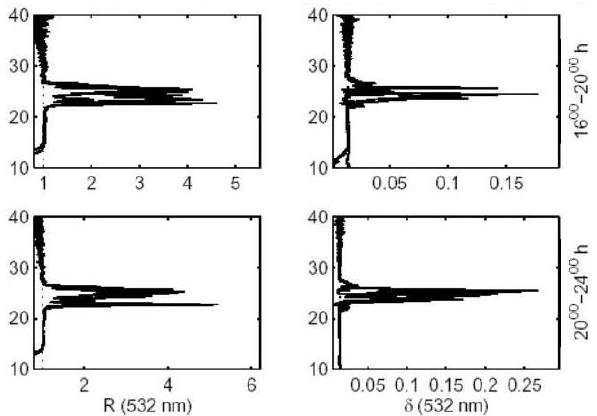
Fig. 7. LIDAR measurements from the Koldewey Station in Ny- ˚Alesund on 7 December 2002. The signals are time averaged Figure 7. LIDAR measurements from the Koldewey Station in Ny-Ålesund on Dec. 7, 2002. from 16:00–20:00 UT and 20:00–24:00 UT, respectively. R is the The signals are time averaged from 16-20 UT and 20-24 UT, respectively. R is the backscatter backscatter ratio as a function of altitude (10–40km). δ is the cor- ratio as a function of altitude (10-40 km). d is the corresponding Depolarization. The responding Depolarization. The wavelength is 532nm. wavelength is 532 nm.